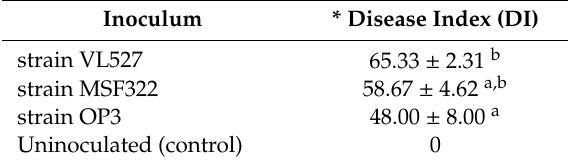
Disease indices in tomato plants inoculated with Chilean C. michiganensis subsp. michiganensis